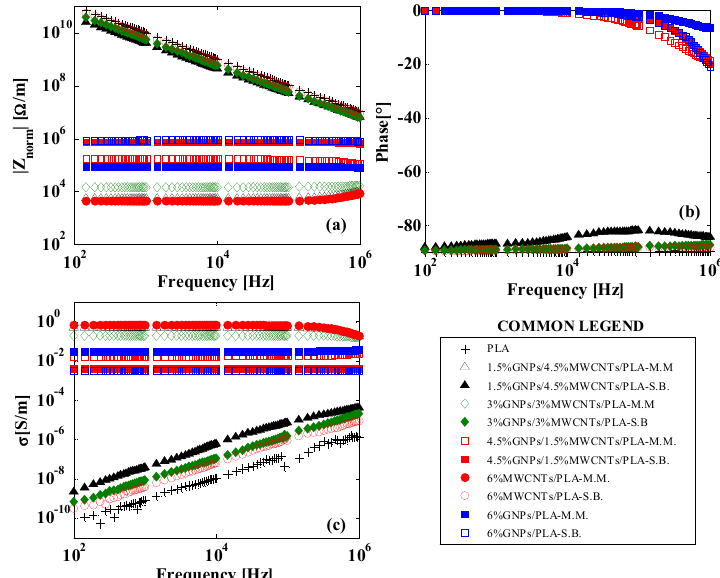
Figure 7. AC electrical properties of the samples in the frequency range of 100 Hz–1 MHz: ( a ) normalized impedance with respect to the sample thickness; ( b ) phase impedance (in degree); ( c ) AC equivalent electrical conductivity.